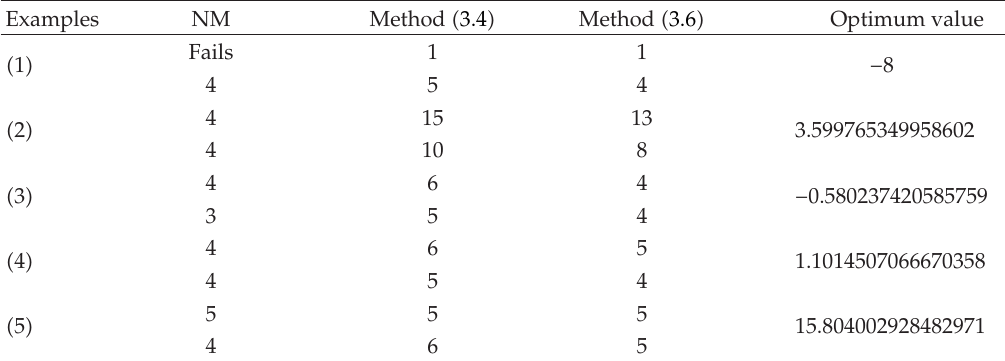
Table 4: Comparison table for unconstrained optimization